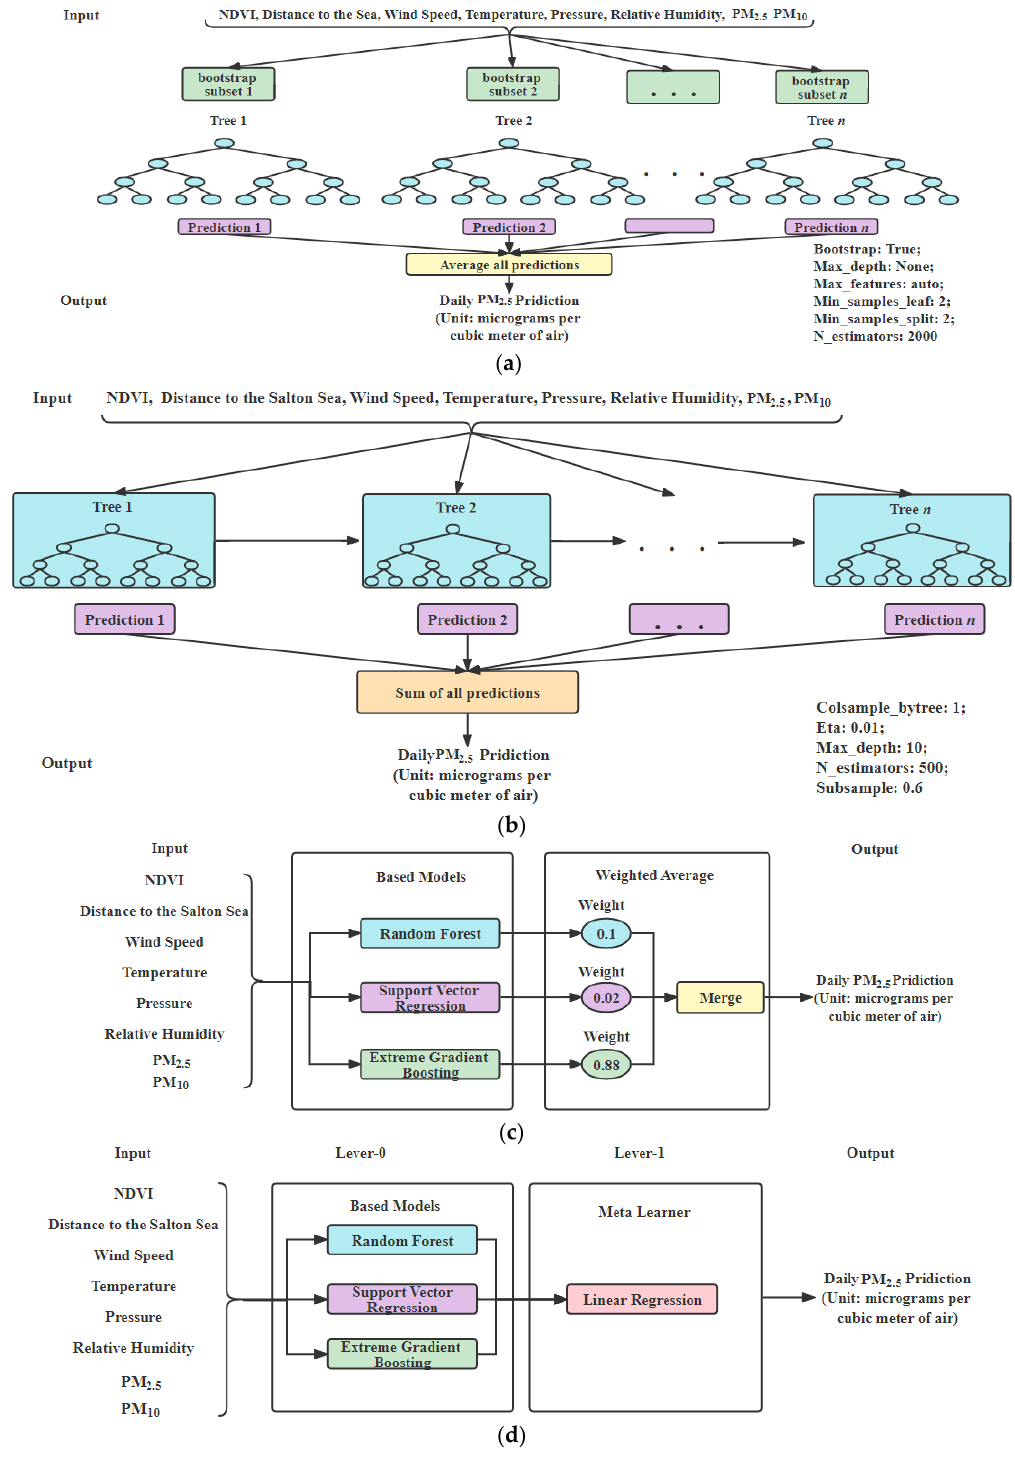
Figure 3. Daily 𝑃𝑀 2.5 prediction models: ( a ) RF Model; ( b ) XGBoost Model; ( c ) ensemble model of weighted average method; ( d ) stacked ensemble model with linear regression (created by author).